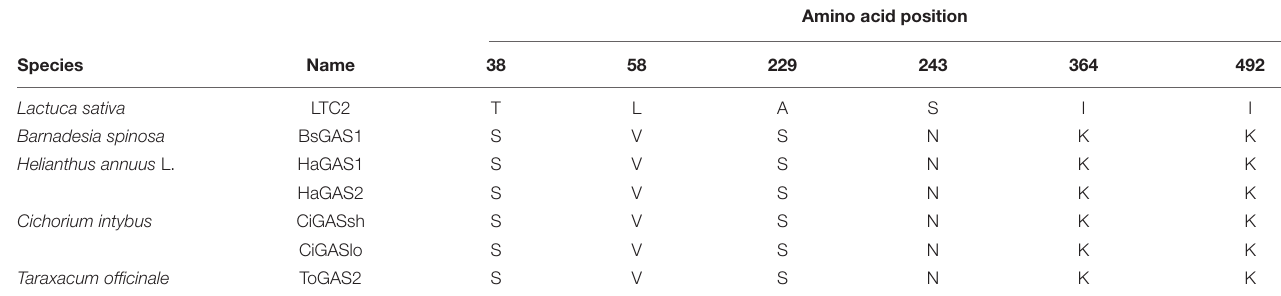
Amino acid position